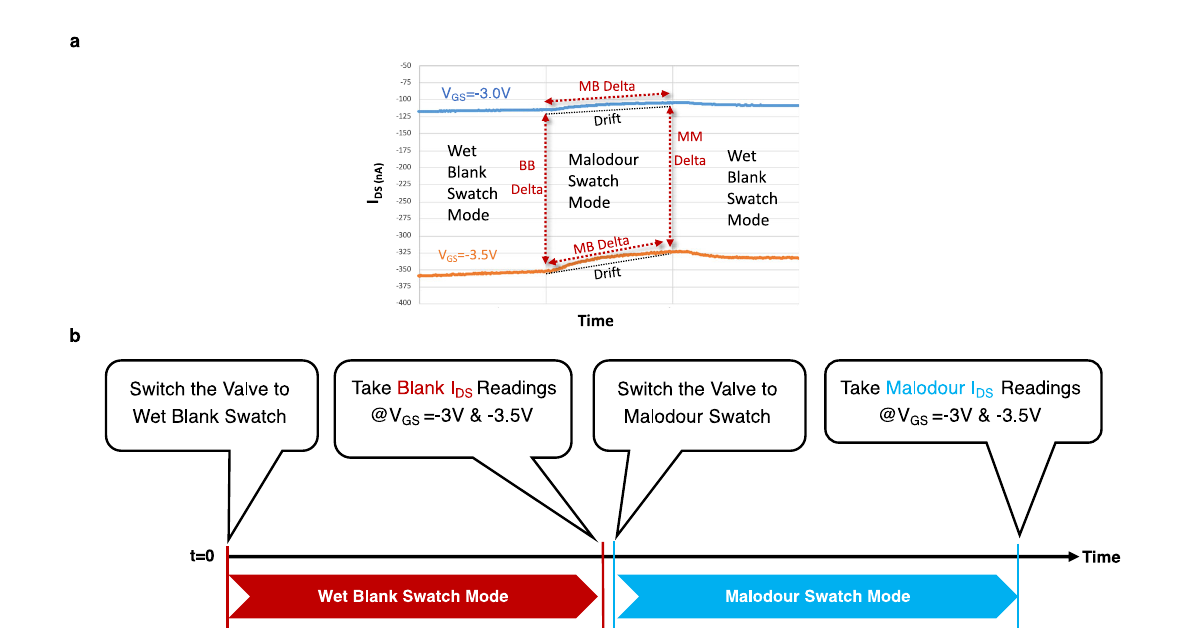
Table 1. The highest-performing (in terms of prediction performance) con fi gurations for both sexes are shown in the fi rst and fourth rows of the table. The highest-performing con fi guration for female datasets achieves 73% average goodness of prediction, which uses 7-bit quan- and the Decision Tree as the ML algorithm. Data quantisation level is the key parameter for assessing the MLE hardware design complexity.